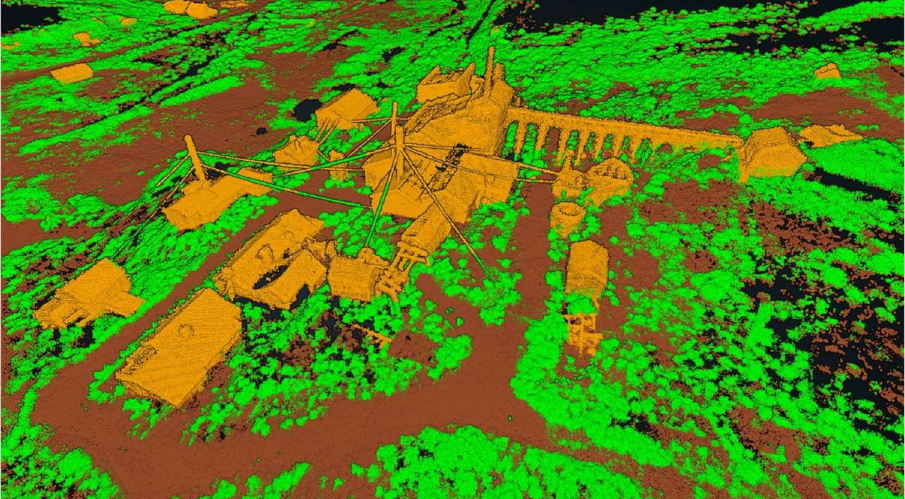
Figure 11. Visualization of our classified 2020 SLAM data documenting the Standard Stamp Mill area in our instance of the Potree viewer. Point cloud classification performed via LASTools using the following classes: buildings = orange; vegetation = green; ground = brown. Visualization by G. Jim é nez